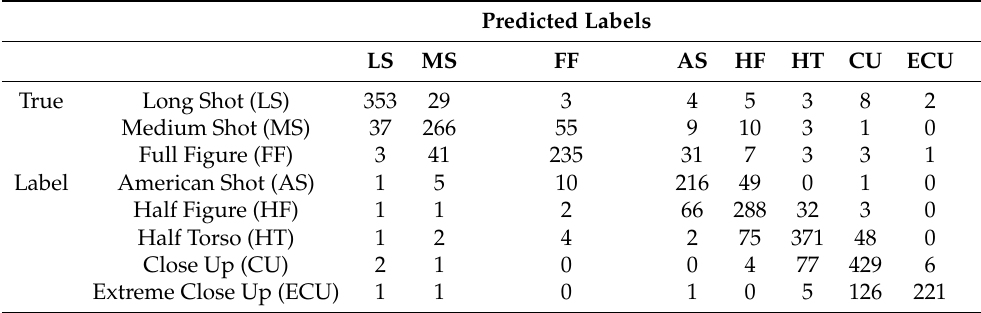
Table 12. Confusion Matrix of a VGG-16 trained on the augmented Original Dataset with the flip on the y-axis and zoom range = 0.3, i.e., Scenario 3.